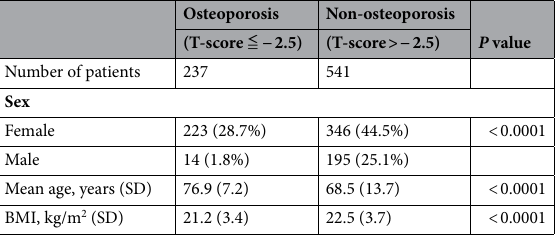
Table 3. Clinical and demographic characteristics of the